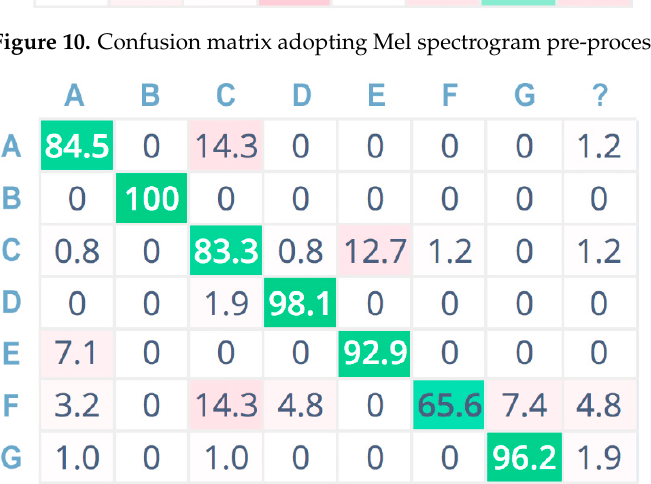
Figure 11. Confusion matrix adopting MFCC pre-processing, 32 bit.